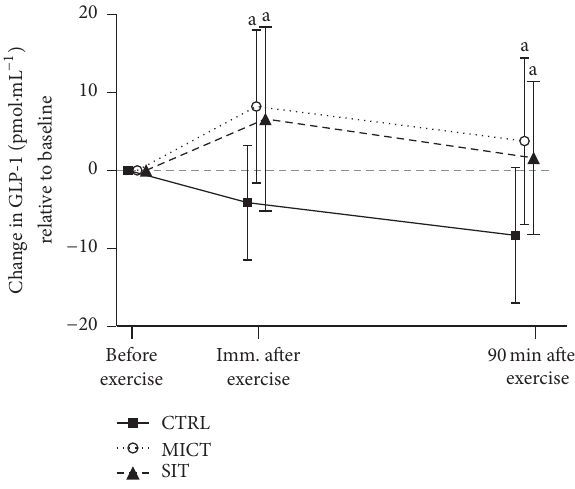
Figure 2: Changes in GLP-1 concentrations across all time points relative to baseline for each experimental session. CTRL: control (no exercise); MICT: moderate-intensity continuous training; SIT: sprint interval training. Note . a Significantly different versus CTRL ( 𝑝 < 0.015 ).